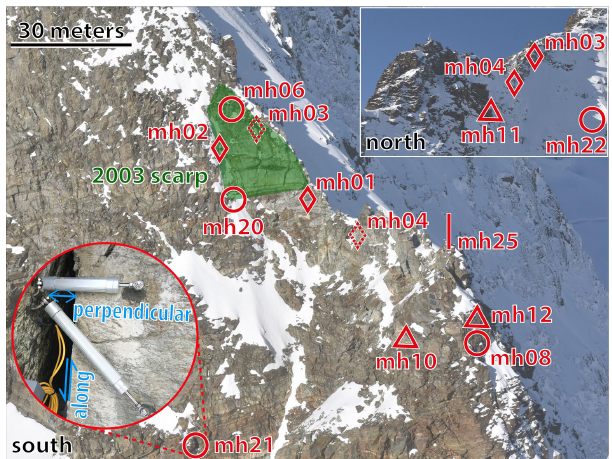
Figure 5. Overview of crackmeter installations. Locations mh01 – mh04 (indicated with ) are instrumented with one crackmeter per- pendicular to the fracture. Locations mh06 , mh08 and mh20 – mh22 (cid:51) (indicated with (cid:13) ) are instrumented with two crackmeters to calcu- late displacements perpendicular to and along fracture. Temperature measurements in fractures exist at most locations. Locations with only rock temperature measurements are indicated with (cid:52) , while | is used for the weather station. Scarp of the 2003 rockfall is shaded